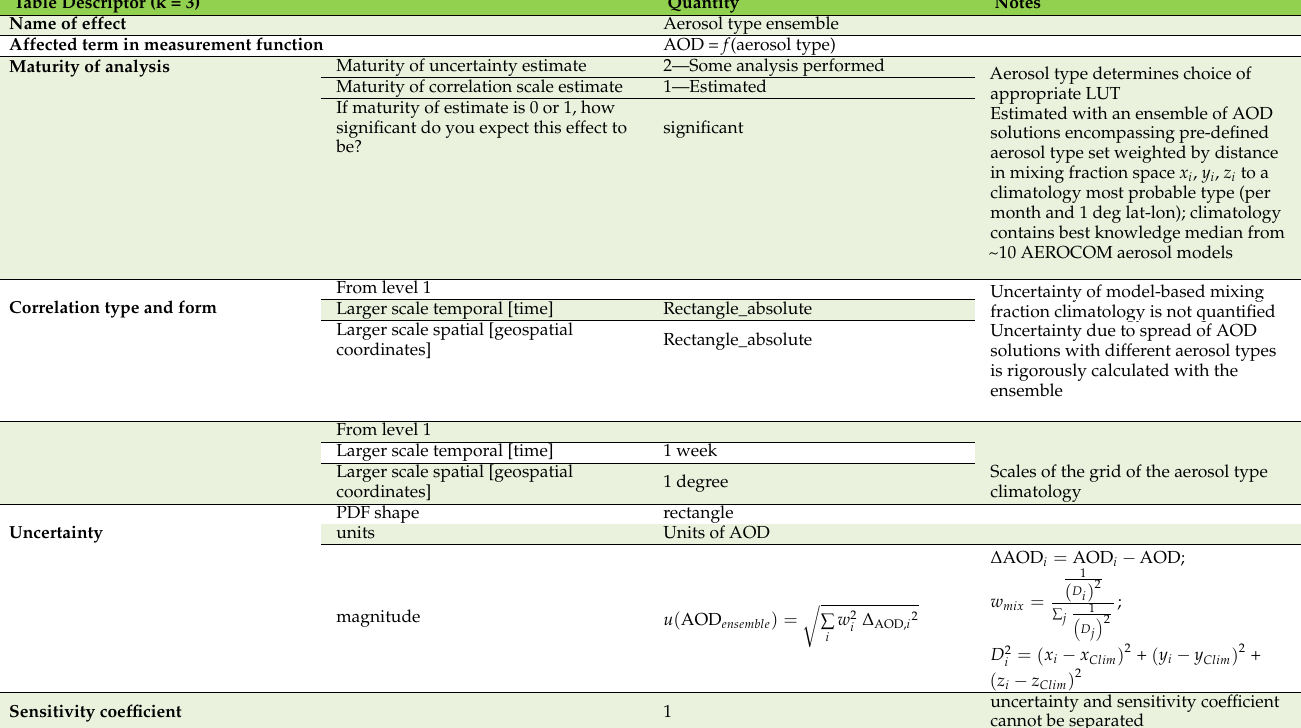
Table 3. Effects table for the aerosol type dependence in the inversion. Table Descriptor (k =